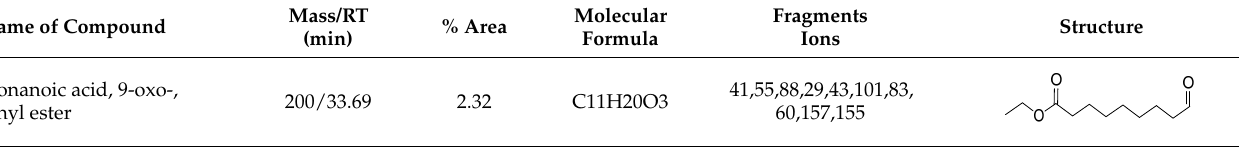
Table 1. Phytochemical compounds identi fi ed from U. dioica essential oil of DCM fraction.